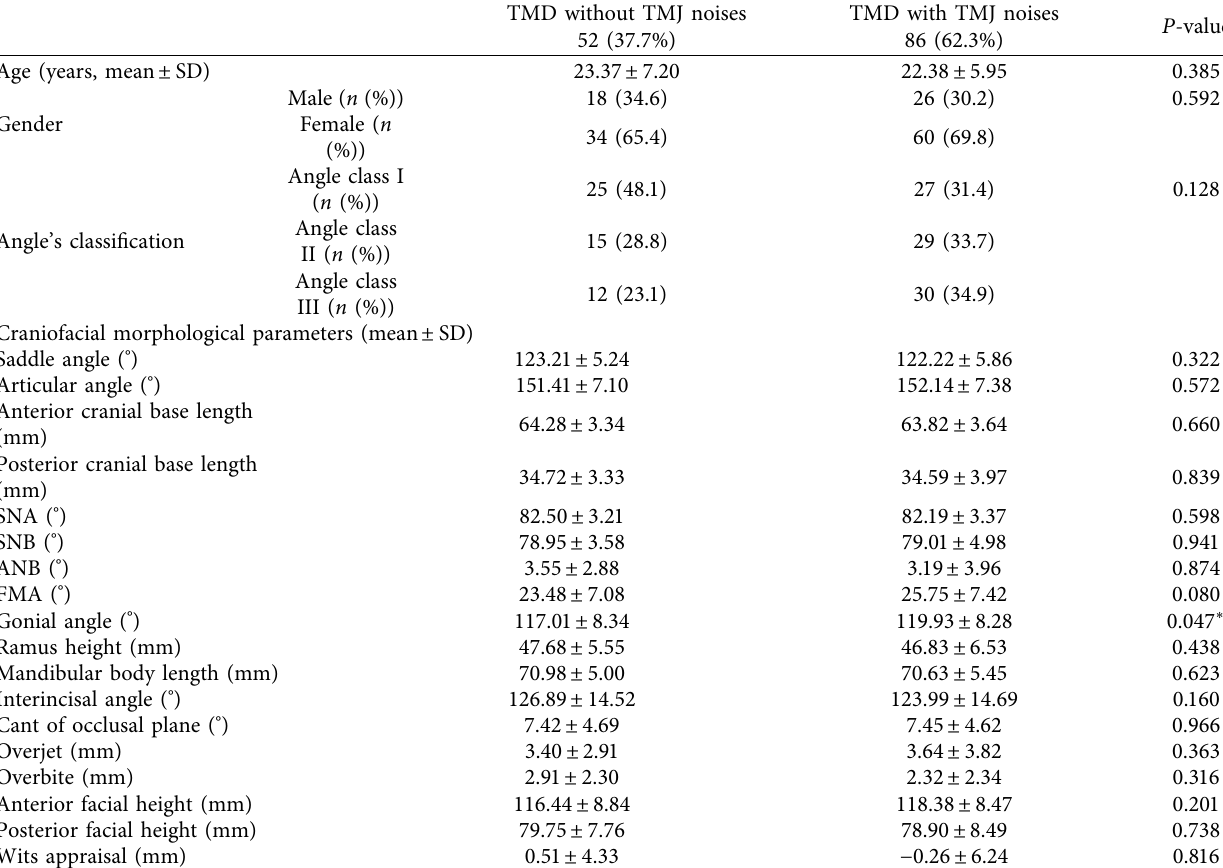
Table 7: Comparison of demographic, occlusal, and craniofacial morphological characteristics between TMD patients with and without TMJ